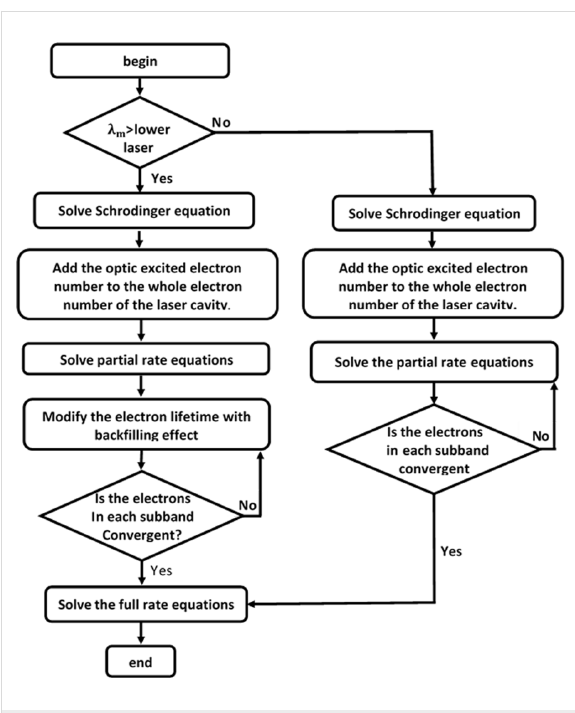
Figure 1: An algorithm for solving the scattering rate and electron dis- tribution for each subband using all-optical modulation.